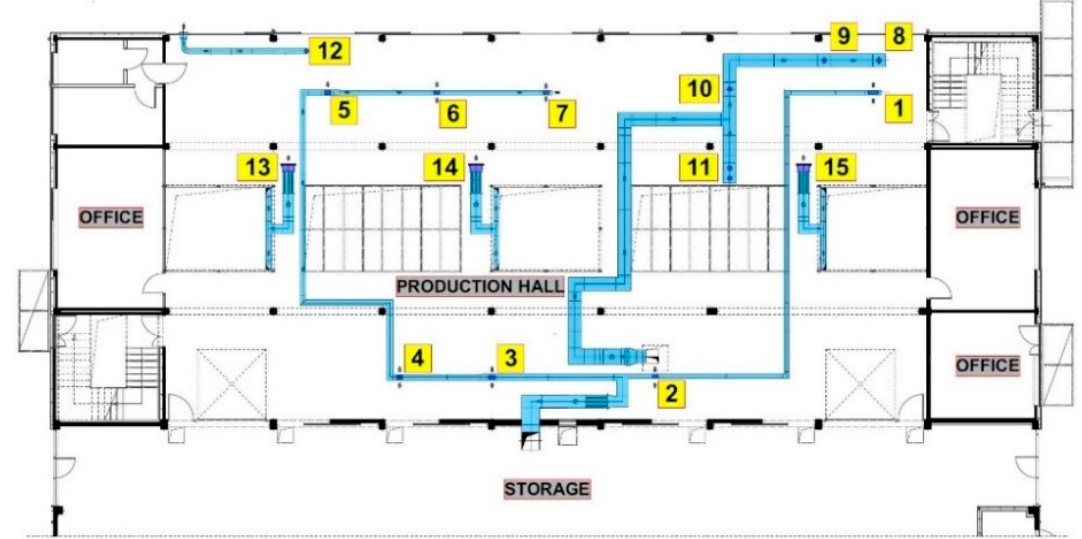
Figure 7. Location of air flow rates’ and temperatures’ measurements trough air duct inlets.